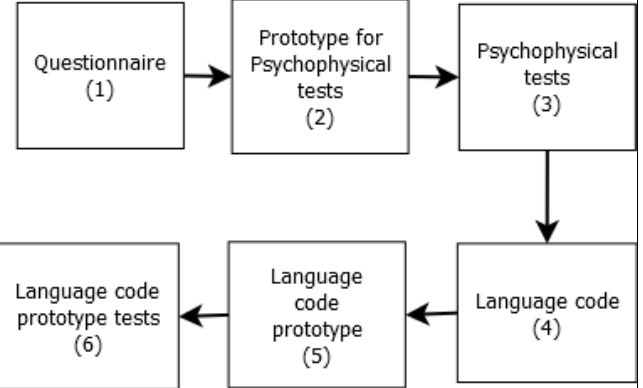
Figure 2: Prototype development procedure.